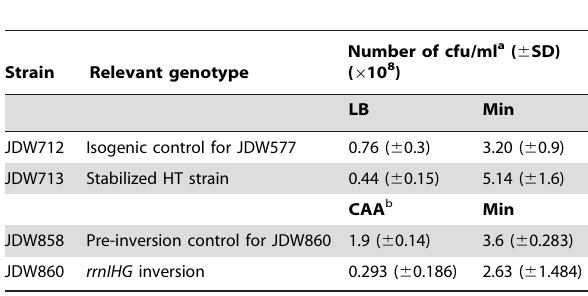
Table 3. Colony-formation by inversion strains in different